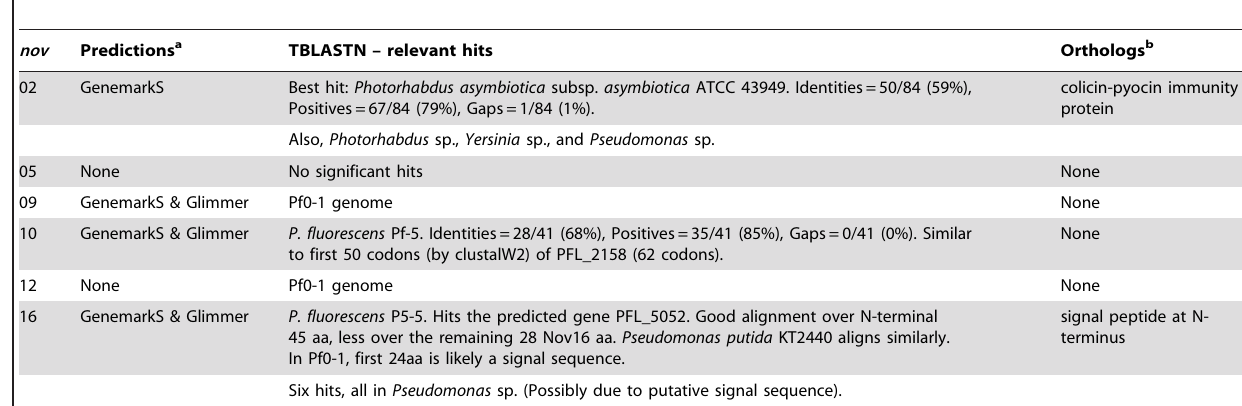
Table 3. Analysis of nov genes located in ‘intergenic’ regions in P. fluorescens Pf0-1.